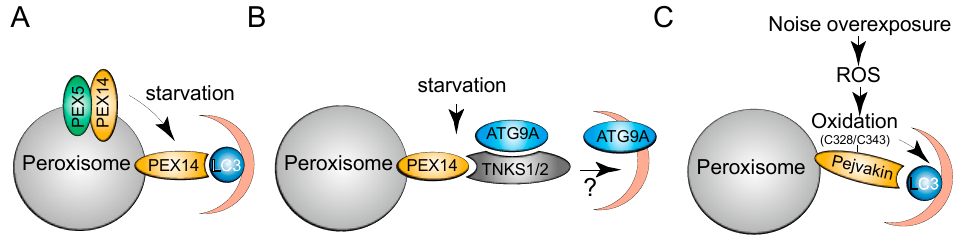
Figure 3. Mechanisms of ubiquitin-independent pexophagy. ( A , B ) LC3 outcompetes PEX5 for binding to PEX14 and sequesters peroxisomes into autophagosomes for autophagic degradation under starvation conditions. In parallel, TNKS1/2 proteins associate with PEX14 and ATG9A and promote starvation-induced pexophagy. ( C ) Noise overexposure increases cellular ROS and causes oxidation of pejvakin at C328/C343, which is required for pejvakin-LC3B interaction and pexophagy.